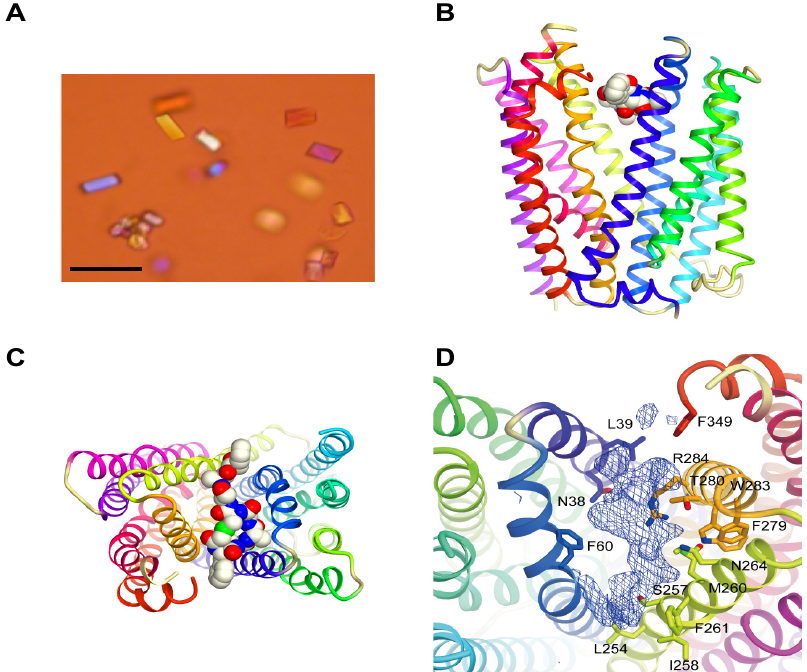
Figure 2. Crystals and crystal structure of the MaD8-PfMATE complex. ( A ) Crystals of the MaD8-PfMATE complex. The scale bar represents 50 µm; ( B ) Side view of the complex structure. Based on the omit map, MaD8, in ball representation, is shown bound between the N- and C-lobes of a selenomethionine-derivative of PfMATE, which is represented in cartoon format; ( C ) Top view of the complex structure. A portion of the C-terminal region of the peptide was not visible in the crystal structure; ( D ) MaD8-binding region. Omit map electron density shows possible π -stacking interaction with the sidechain of F349 of